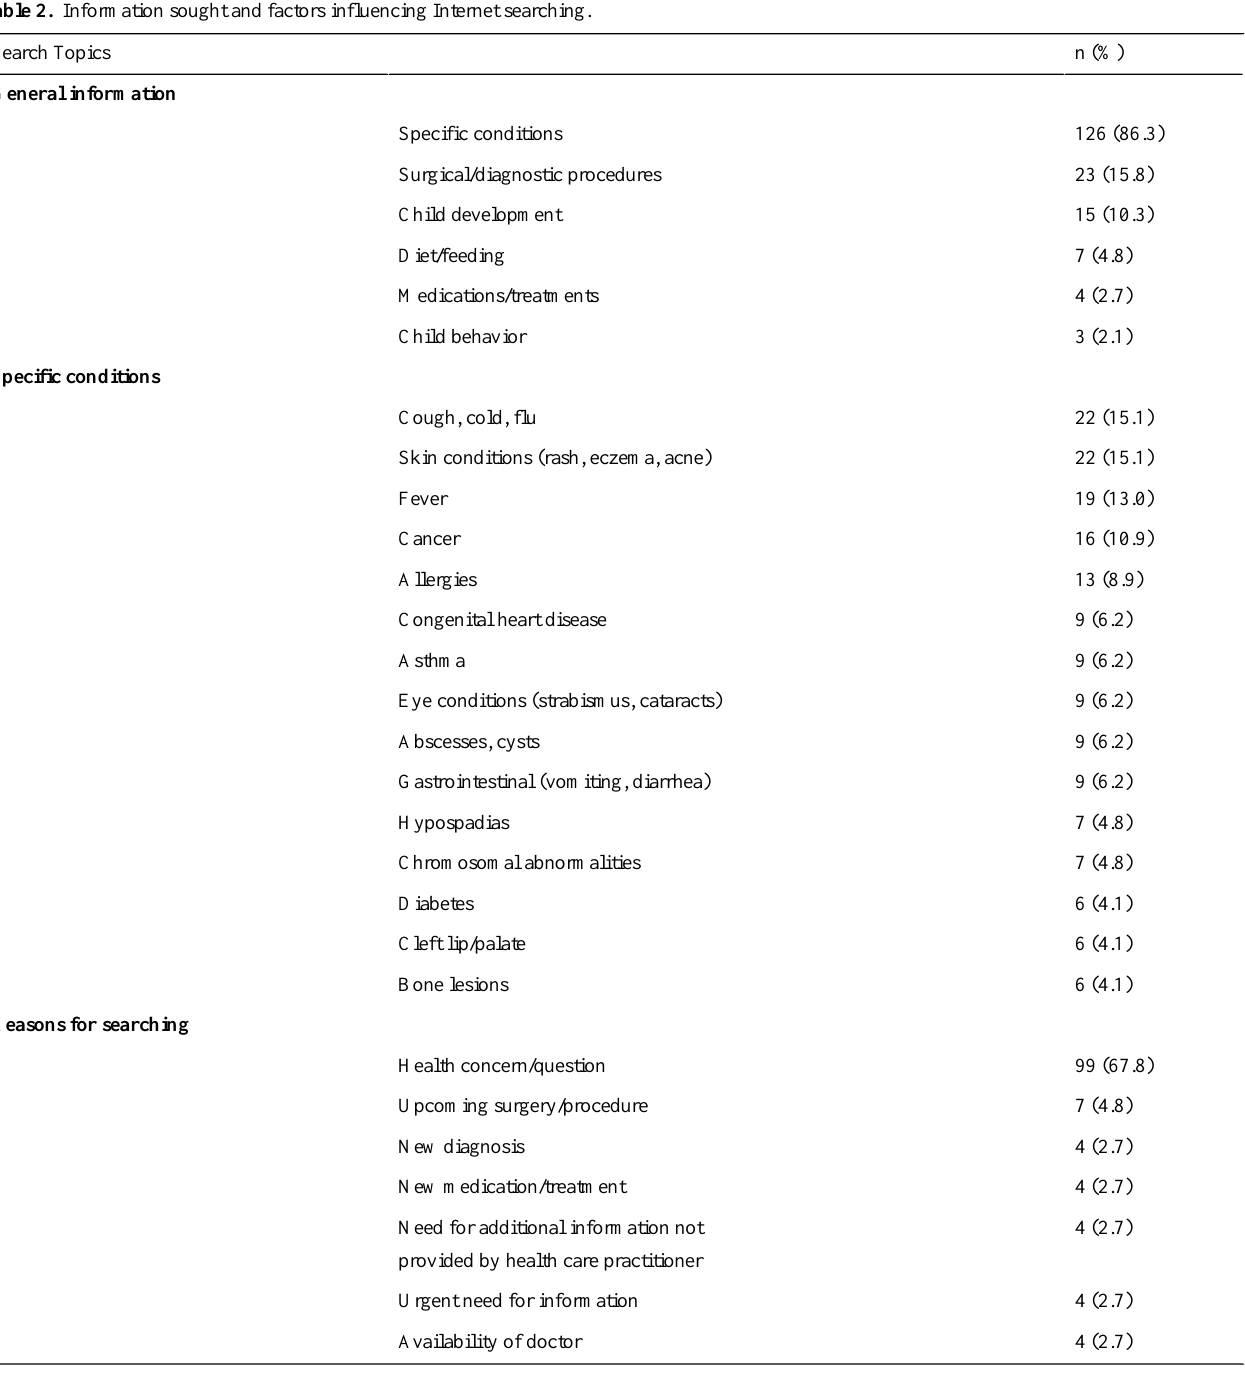
Table 2. Information sought and factors influencing Internet